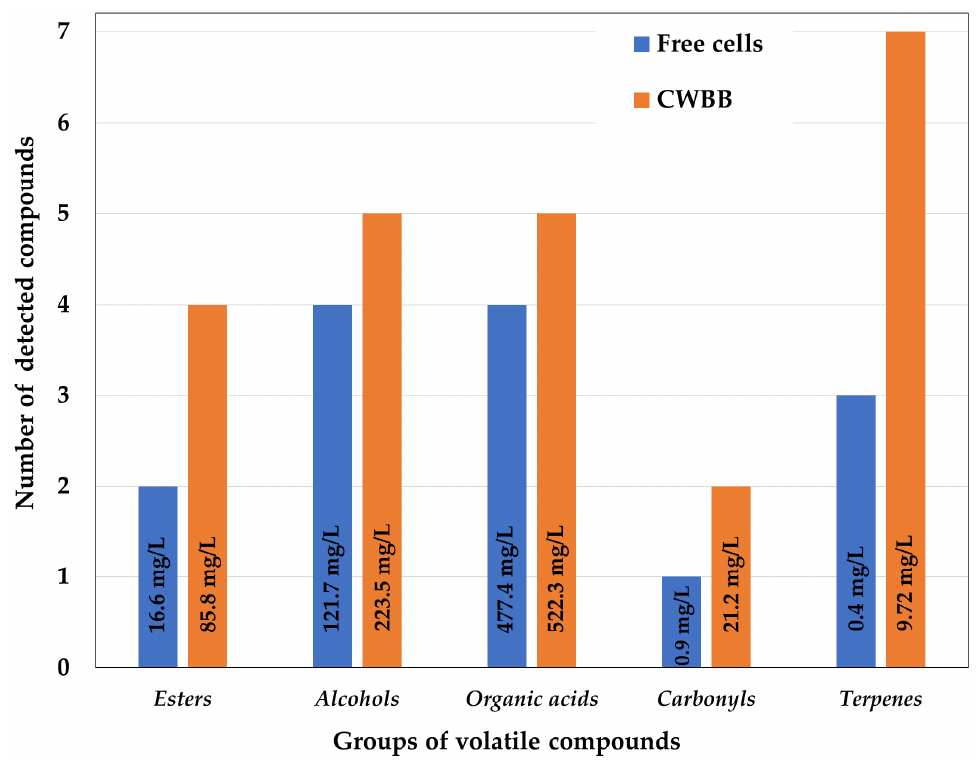
Figure 2. Number and content of volatile compounds (mg/L) detected in beer produced at 10 °C with free yeast cells or with the CWBB biocatalyst.